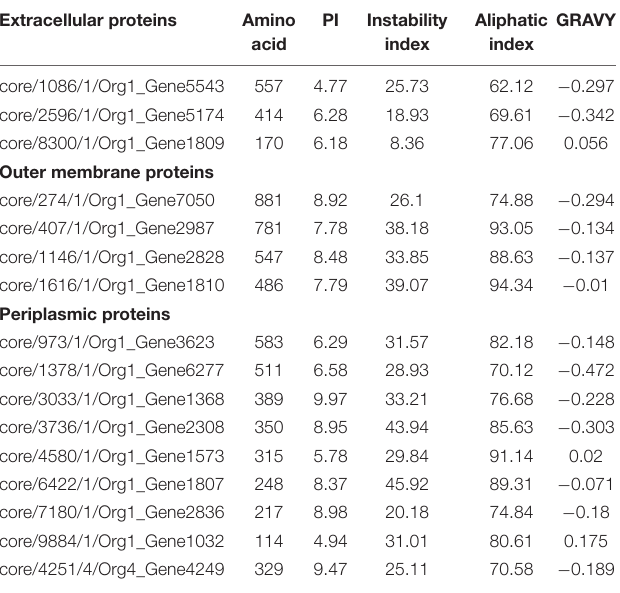
TABLE 3 | Physico-chemical properties of good vaccine